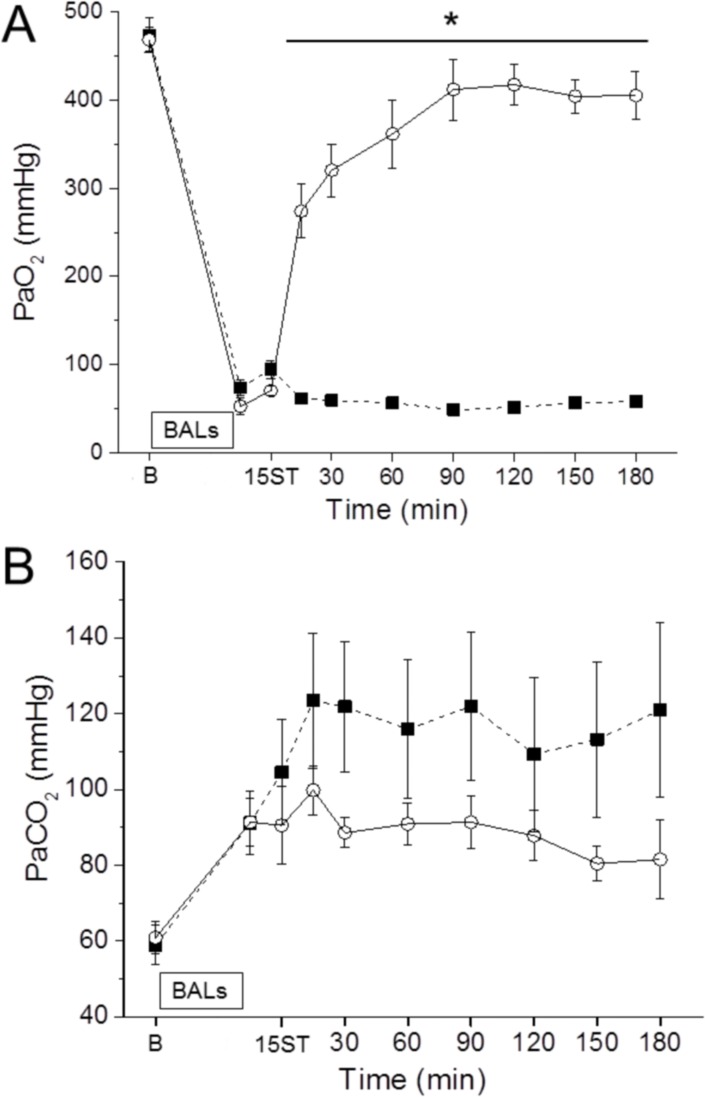
Gas exchange of surfactant-depleted rabbits.(A) Mean PaO2 and (B) PaCO2 values in animals managed just with nasal CPAP for 180 min (solid squares) and in animals treated with 200 mg/kg of surfactant following the InsSurE approach and managed further for 180 min in nasal CPAP (empty circles). There were no differences between the experimental groups before the induction of respiratory distress (baseline, B in the X-axis). The time point 15ST refers to the 15 min stabilization period established to confirm the respiratory distress induced by repeated broncho-alveolar lavages (BALs). N = 6 and N = 9 in the Control and InSurE groups, respectively. * P vs. Control < 0.05.